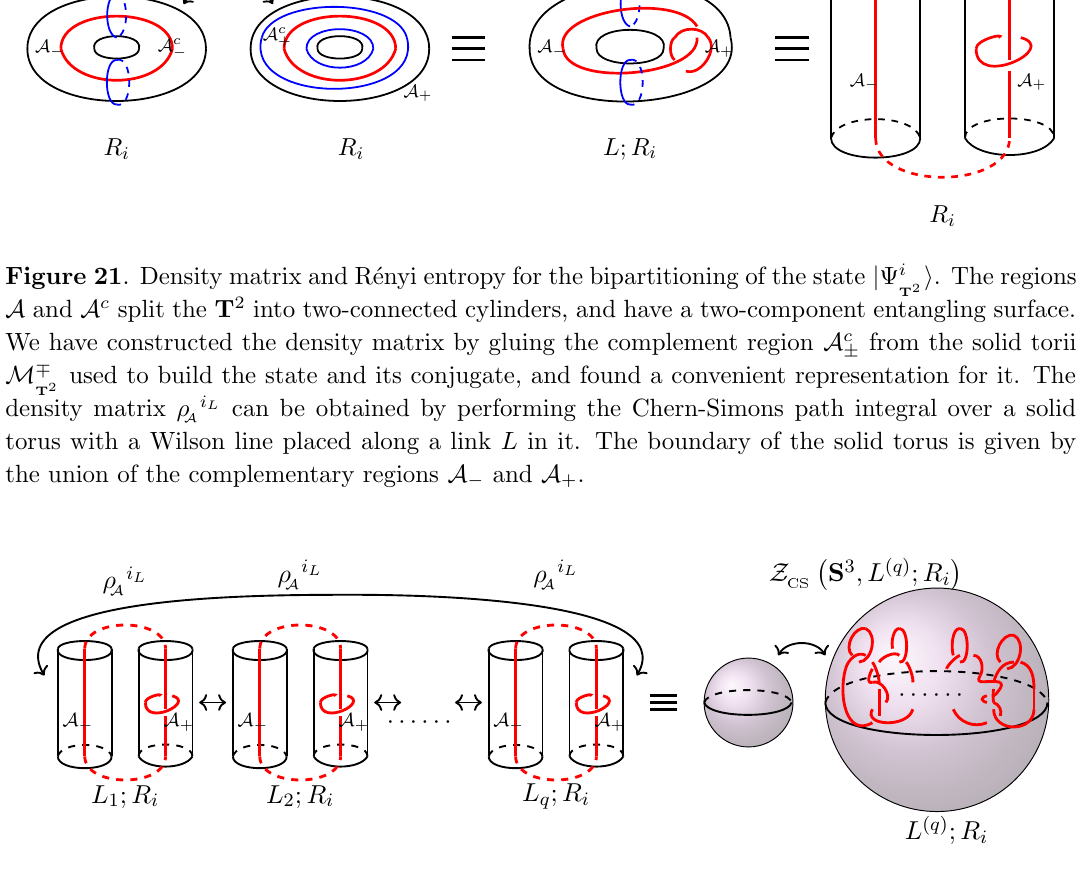
Figure 22 . To compute the q th -R(cid:19)enyi entropy for the reduced density matrix (cid:26) cyclically glue copies of the solid torii with a link L carrying representation R i on each of its components. As indicated in (cid:12)gure 21 it is helpful to view this solid torus in terms of gluing together two solid cylinders with a link L contained within them. Gluing these together we see that we are required to compute the path integral over S 3 with a Wilson line representation R i placed along the direct sum of links L ( q ) = L 1 + (cid:1) (cid:1) (cid:1) + L q . The q links get intertwined in the process of identifying the pieces of the density matrices across replica